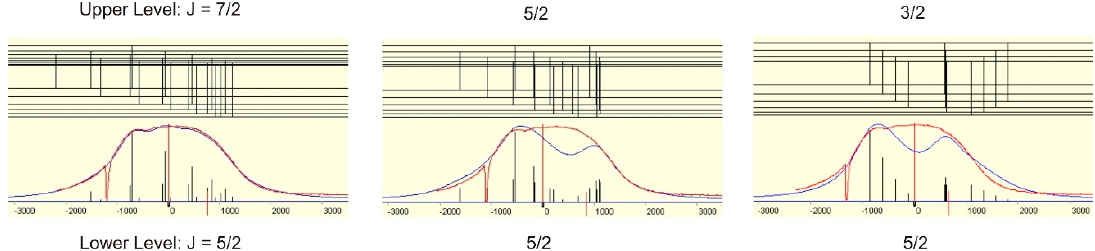
Figure 4. Simulation of the observed hf pattern of the line at 5683.40 Å assuming different values for the total angular momentum of the new fine structure level.